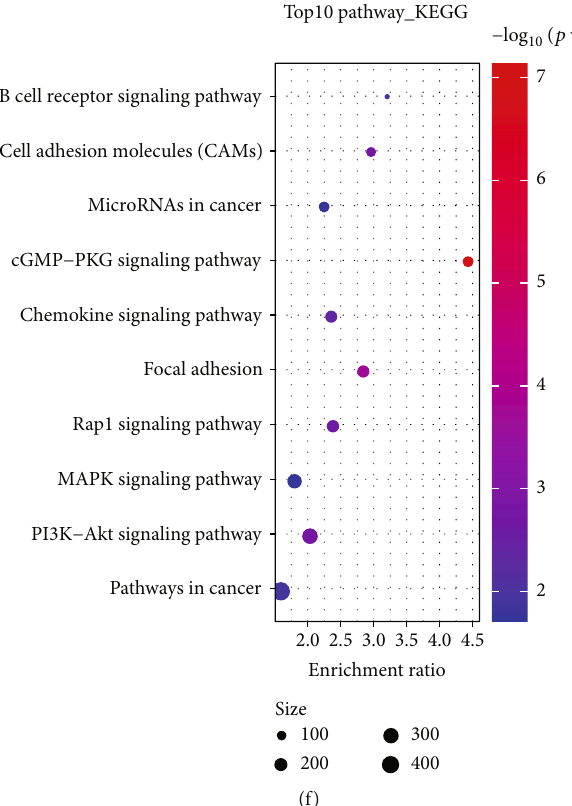
Figure 7: Immune-related di ff erential gene expression analysis. (a) Intersection of upregulated genes among NCAPG, StromalScore, and ImmuneScore groups; (b) the intersection of downregulated genes among NCAPG, StromalScore, and ImmuneScore groups; (c – f) GO annotation and KEGG functional enrichment analyses for DEGsin NCAPG, StromalScore, and ImmuneScore